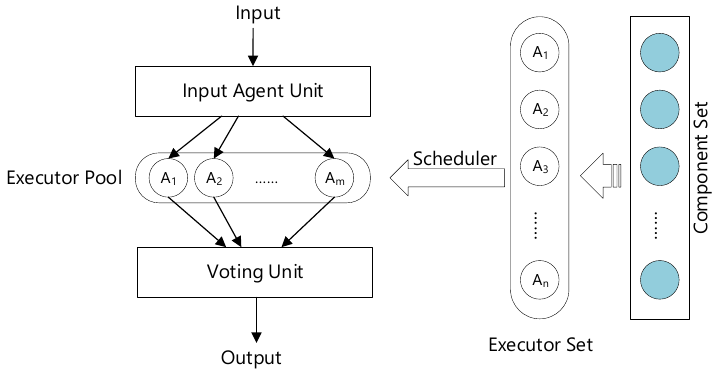
Figure 1. The dynamic heterogeneous redundancy